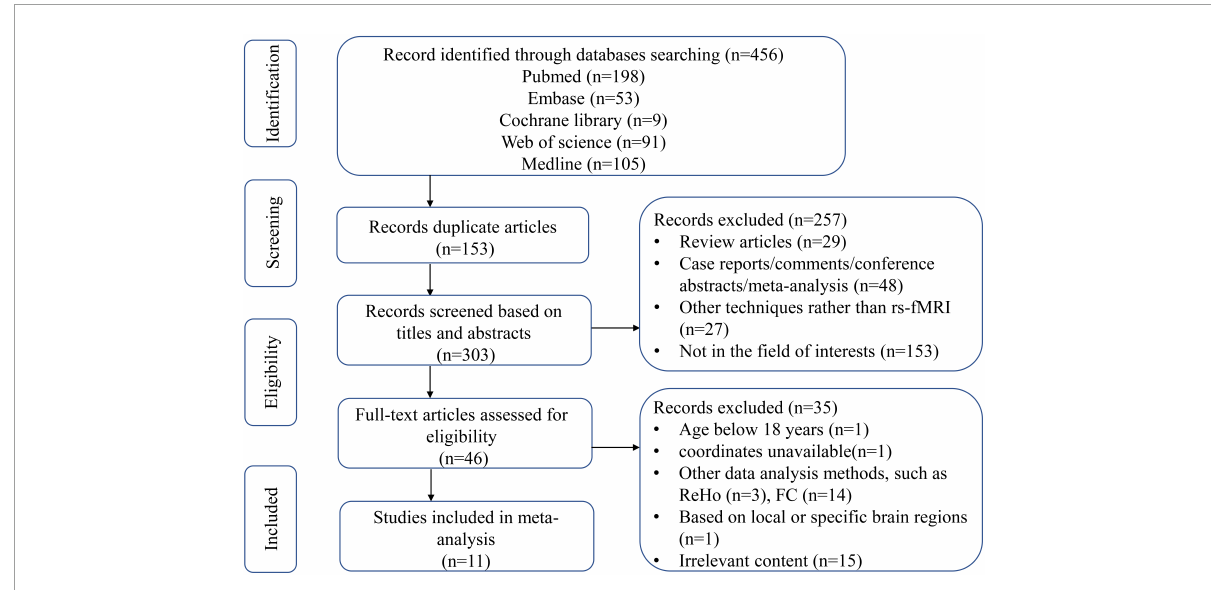
FIGURE1 Flow diagram of article selection. ReHo, regional homogeneity; FC, functional